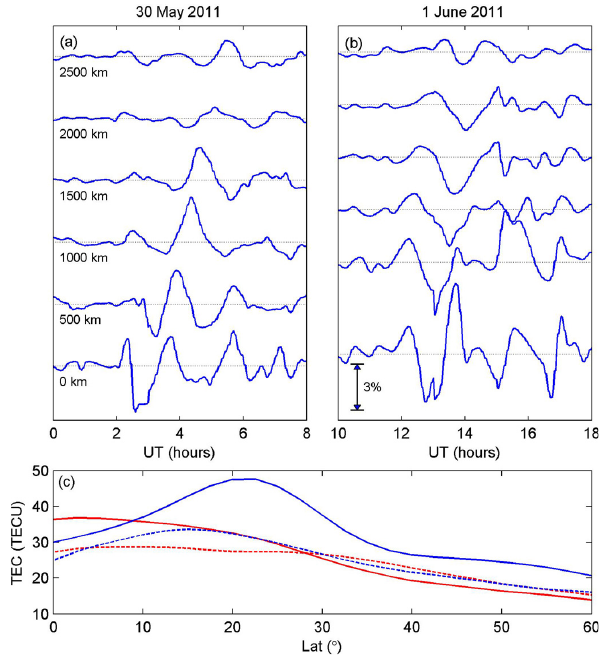
Fig. 6. (a) , (b) Temporal variations in relative amplitude at fixed horizontal locations, x , ranging from 0 to 2500km at intervals of 500km. (c) Latitudinal variations in background TEC along the 105 ◦ E meridian during the time of the two events (solid lines) and during quiet time (dashed lines). Solid lines are the latitudinal vari- ation in TEC at 02:00UT on 30 May (red) and at 12:00UT on 1 June (blue). The two times correspond to the times of the two LSTID events that occurred in China. Dashed lines represent the corresponding mean values during quiet days on 24–26